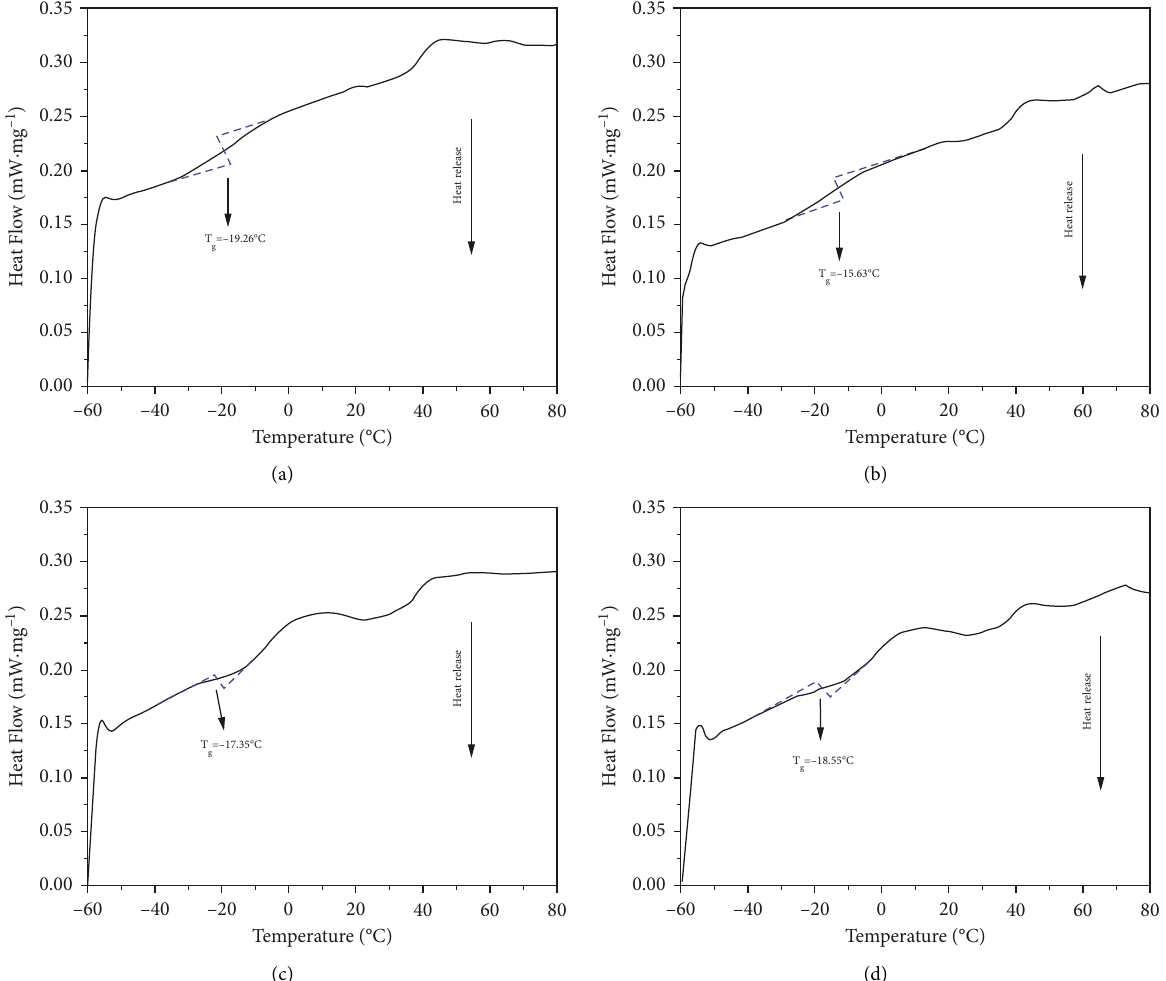
Figure 2: DSC diagram of the original, aged, and rejuvenated asphalt: (a) original asphalt, (b) aged asphalt, (c) WEOB-rejuvenated asphalt, (d) and WEOB-S-rejuvenated